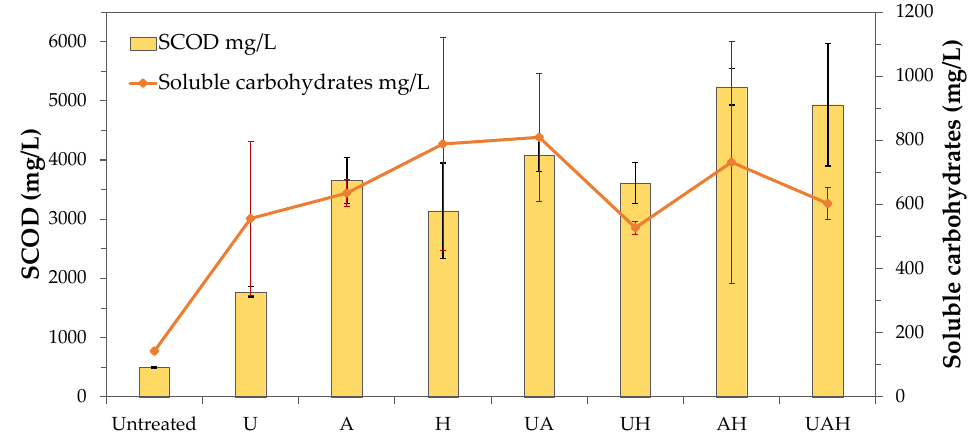
Figure 2. Comparison of different pretreatments in terms of SCOD and carbohydrates.